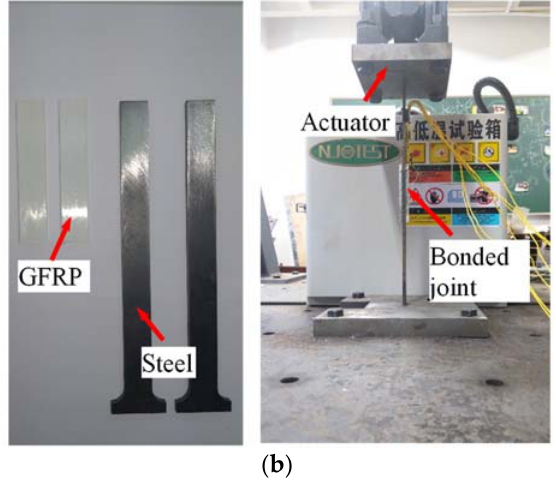
Figure 2. The GFRP–steel double ‐ strap joints and the tensile test graph. ( a ) Dimensions of the GFRP–steel double ‐ strap joints; ( b ) raw materials and test loading graph of the double ‐ strap joint.